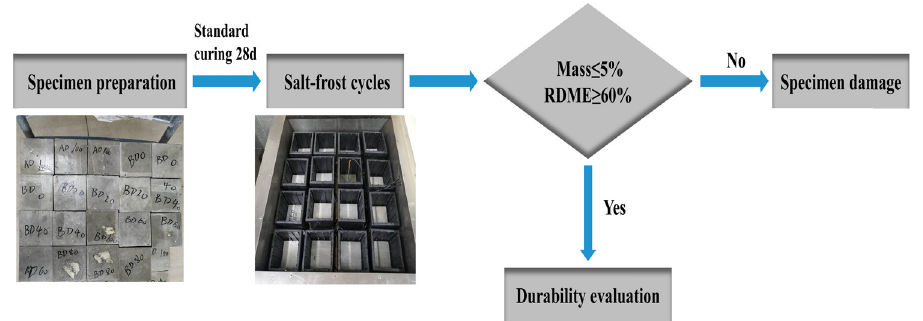
Figure 3: Test fl ow chart of salt - frost